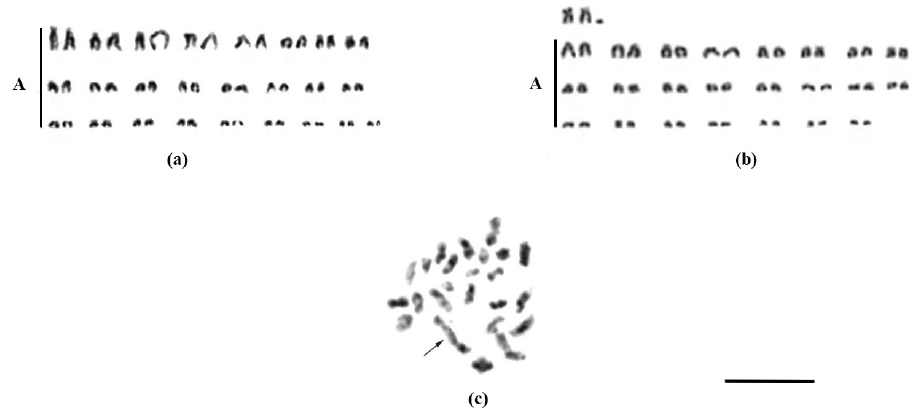
Figure 2. Karyotypes of Nothobranchius brieni a somatic chromosomes of female b somatic chromo- somes of male c meiotic metaphase I (testicular). (A – acrocentric chromosomes). Note trivalent chromo- some (arrowed). Scale bar: 10 µm.